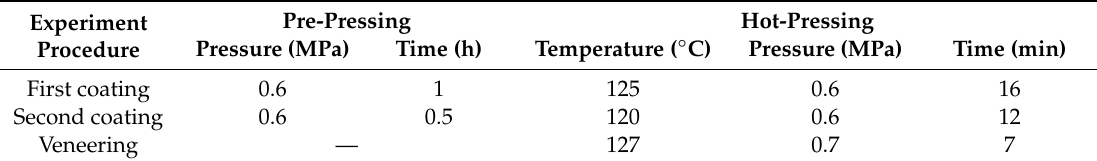
Figure 2. Production process of flame-retardant ecological board. Table 2. The parameters in the process of pressing.